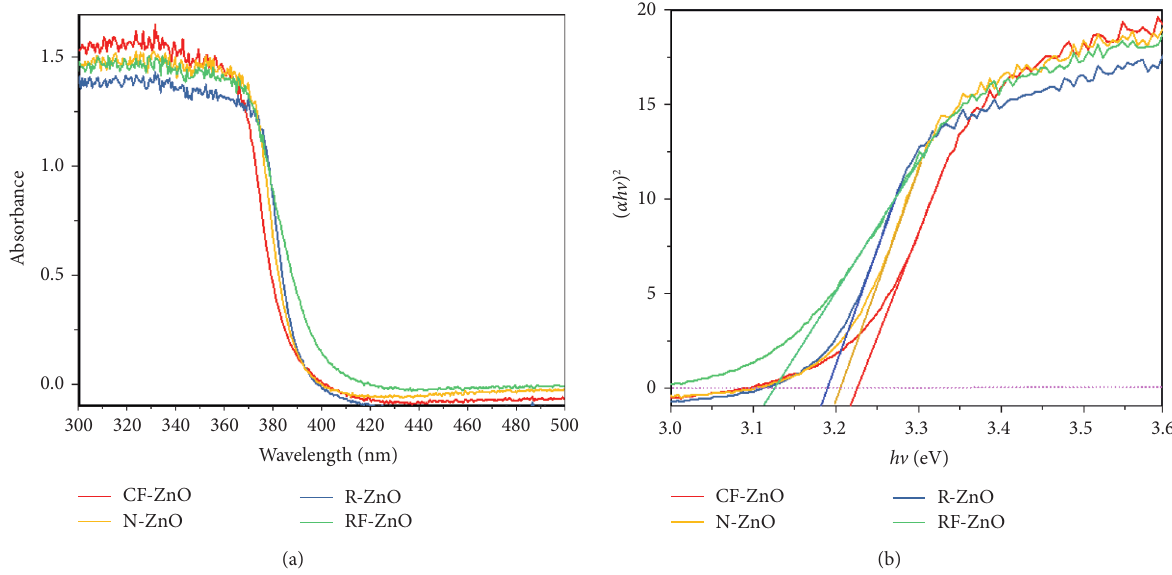
Figure 5: UV-Vis diffuse reflectance spectra and Tauc’s plots of the as-prepared